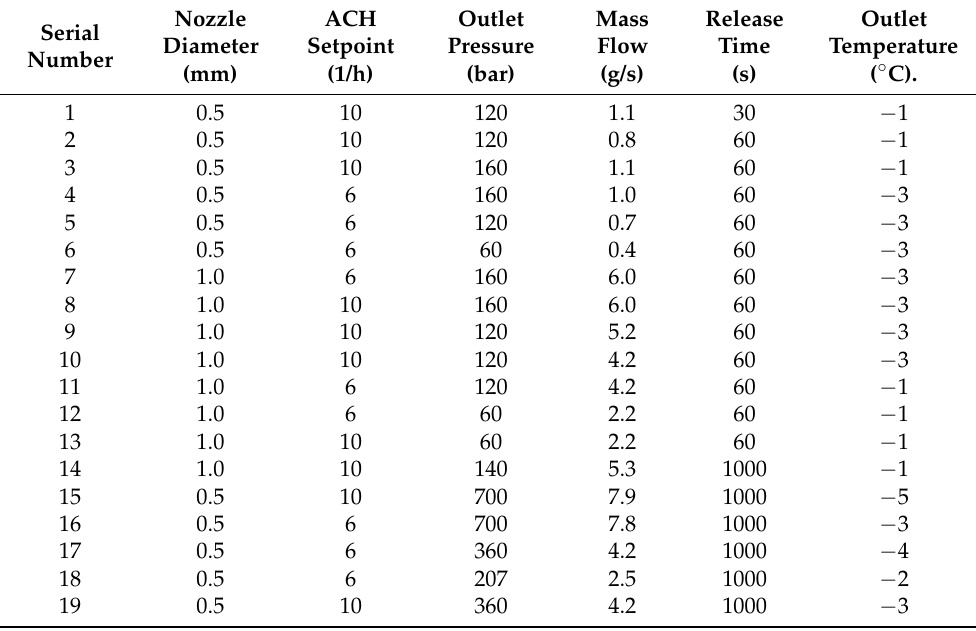
Table 3. Hydrogen diffusion test parameter